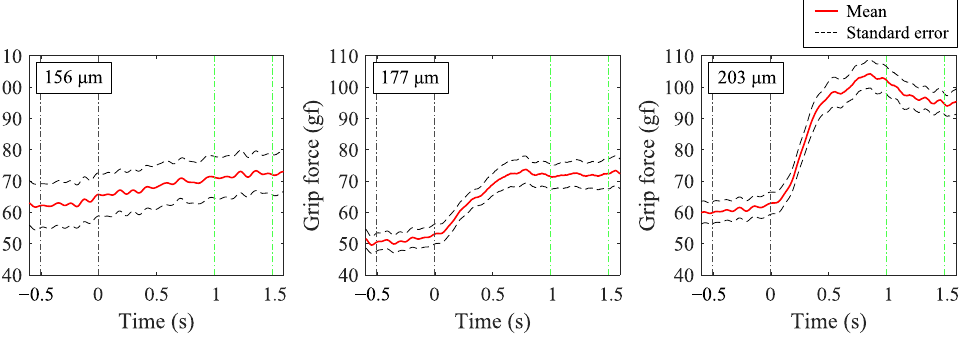
Figure 4. Grip force over time during Experiment 2. The red lines and dashed black lines indicate the means and range of standard errors, respectively. Stimuli started at 0 s and lasted 3 s. For the analysis of the change in grip force, means of 0.5 s before the stimulus ( − 0.5–0 s) and after the stimulus (1–1.5 s), which are surrounded by the black and green dashed lines, respectively, were used.